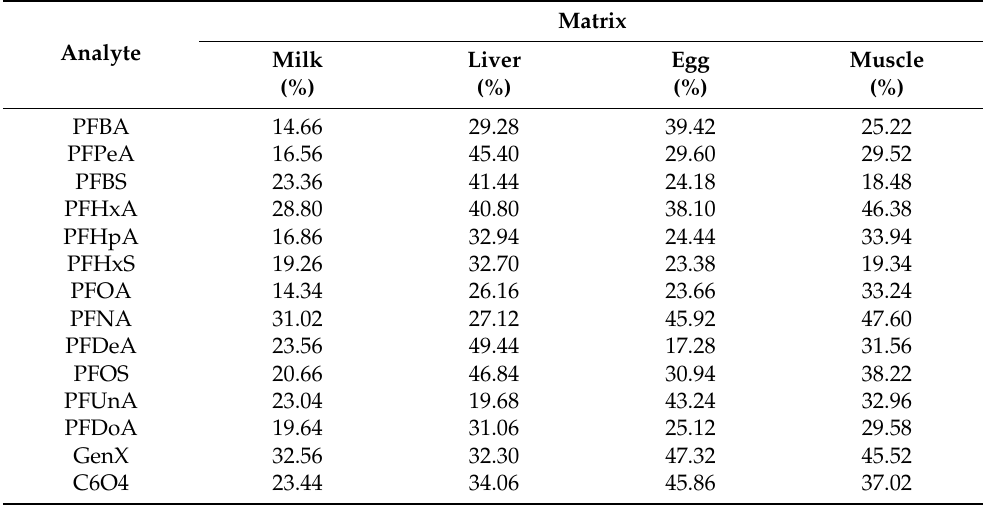
Table 4. Expanded relative measurement uncertainties calculated according to NMKL procedure No. 5